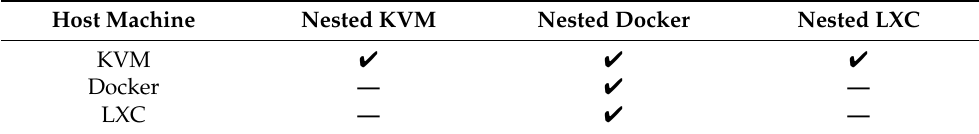
Table 2. Nested virtualization and containerization